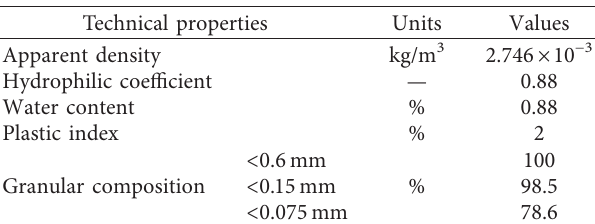
Table 5: Technical properties of the mineral powder in this paper.